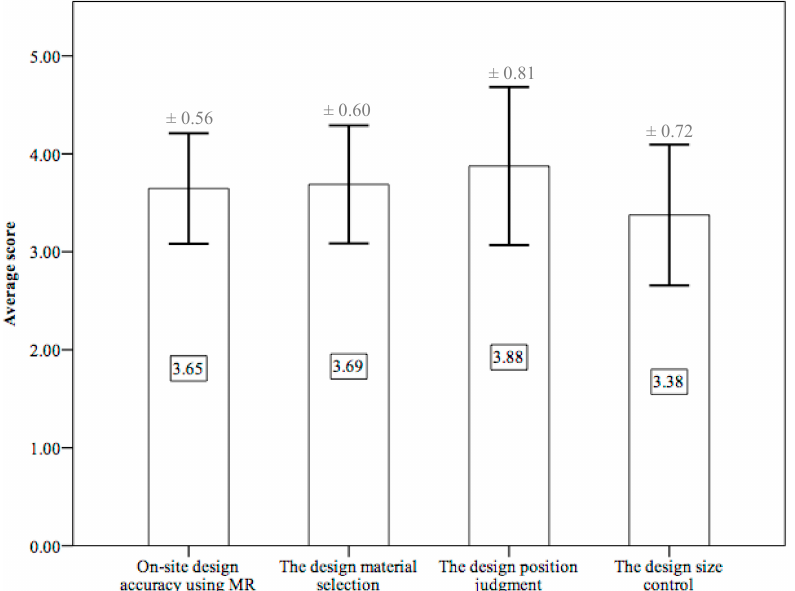
Figure 11. The mean and standard deviation of the score for on-site design accuracy using MR, design material selection, design position judgment, and design size control.